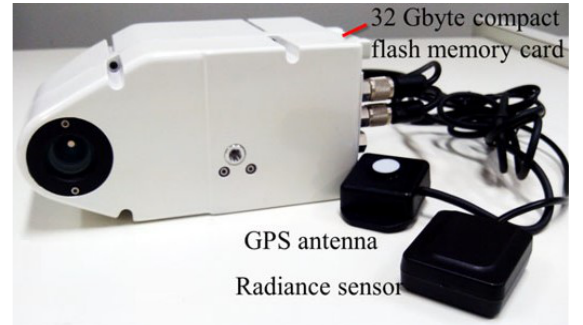
Figure 2. FPI camera used in this study.